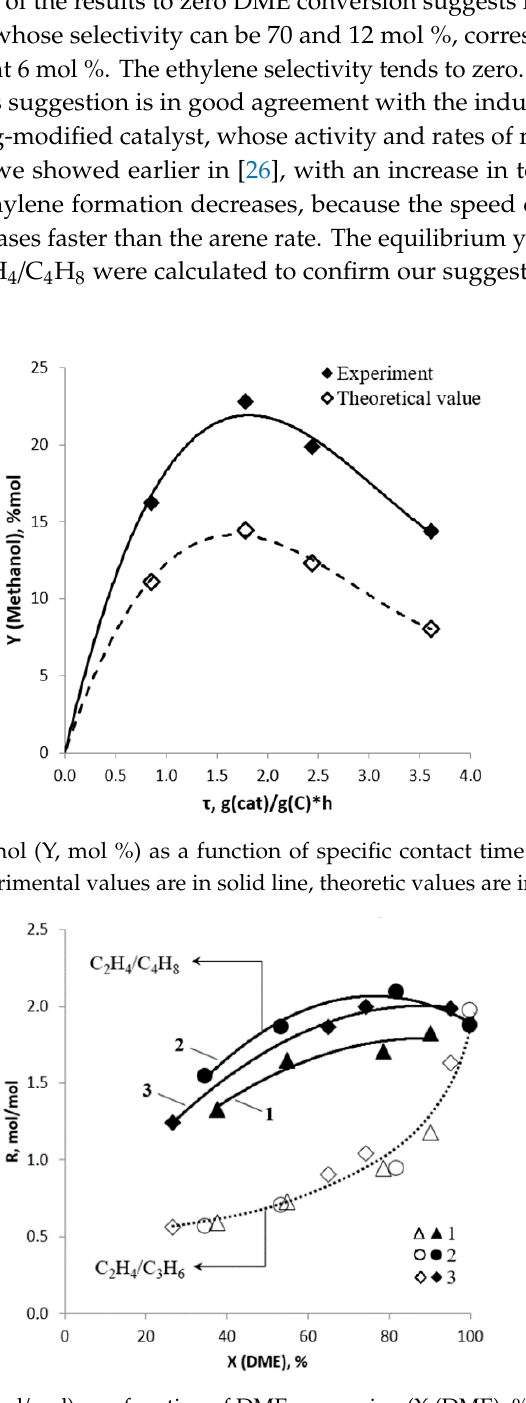
Figure 8. Molar ratio (R, mol / mol) as a function of DME conversion (X (DME), %). 1—HZSM-5 / Al 2 O 3 ; 2—Zr-HZSM-5 / Al 2 O 3 ; 3—Mg-HZSM-5 / Al 2 O 3 . C 2 H 4 / C 3 H 6 —dashed line; C 2 H 4 / C 4 H 8 —solid line.